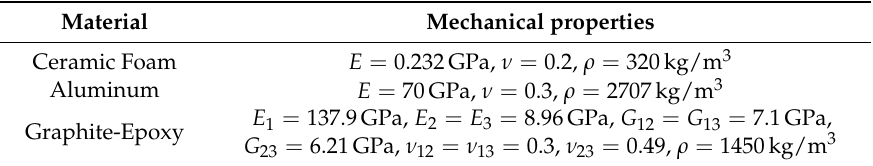
Table 2. Mechanical properties of the materials employed in the numerical analyses.